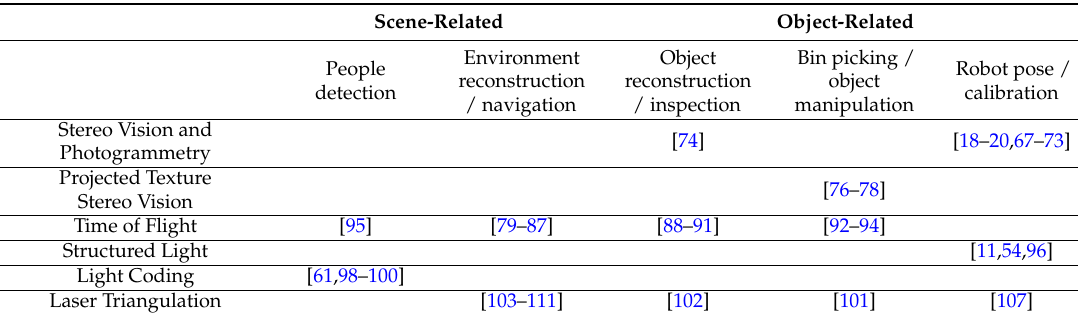
Table 4. Common applications in